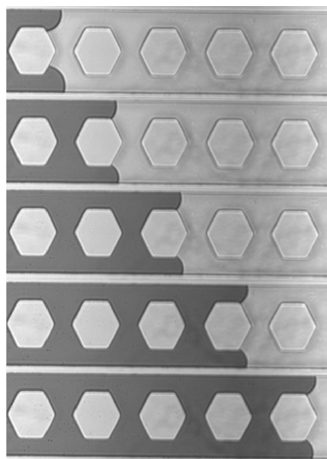
Figure 6. ( a ) Schematic diagram of the experimental apparatus; and ( b ) close-up image of the obstacles.